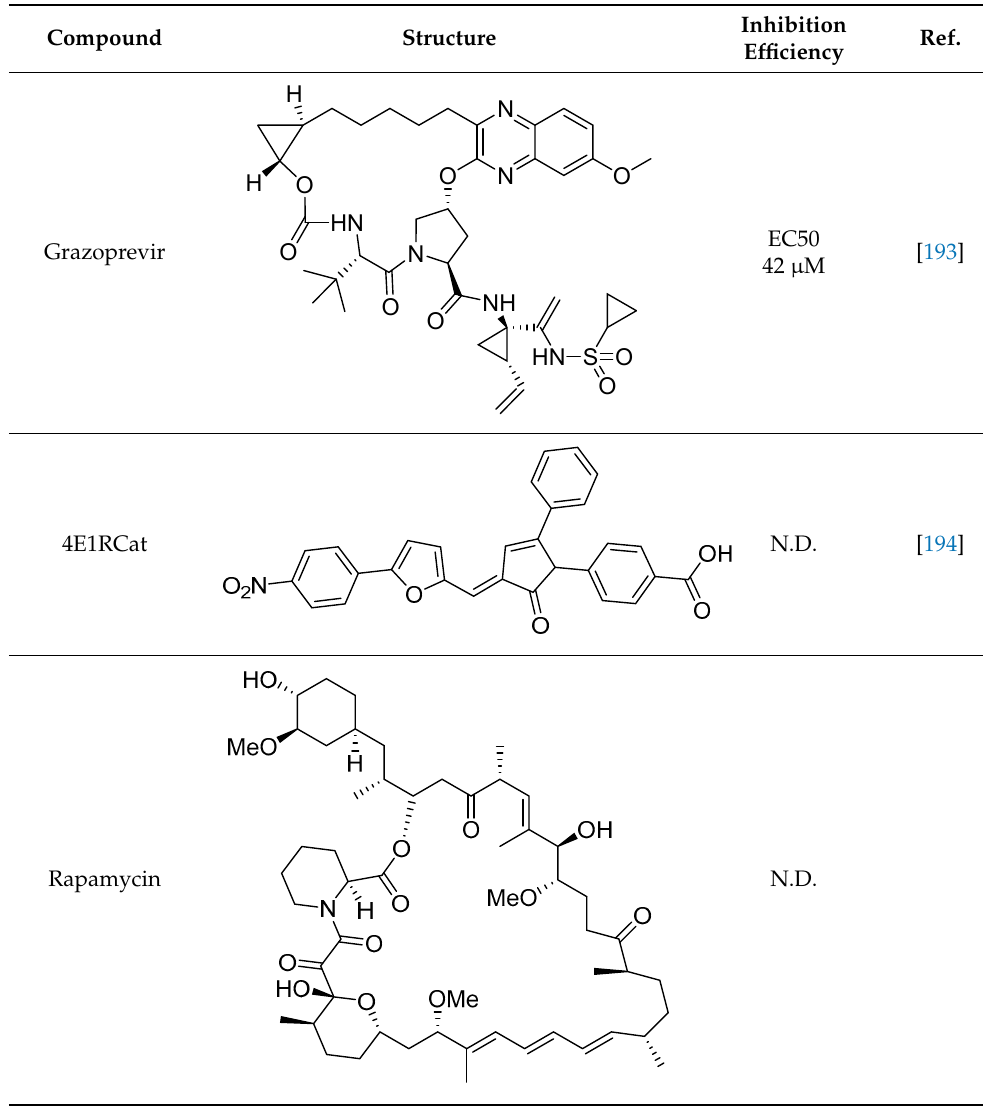
Table 4. Cont. Compound Structure